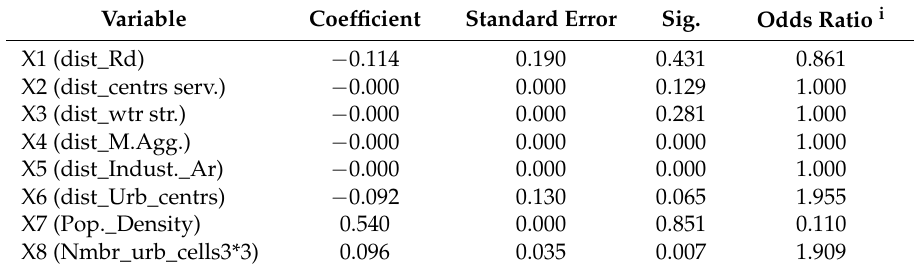
Table 6. Coefficients and odds ratios for the LRM containing the eight independent